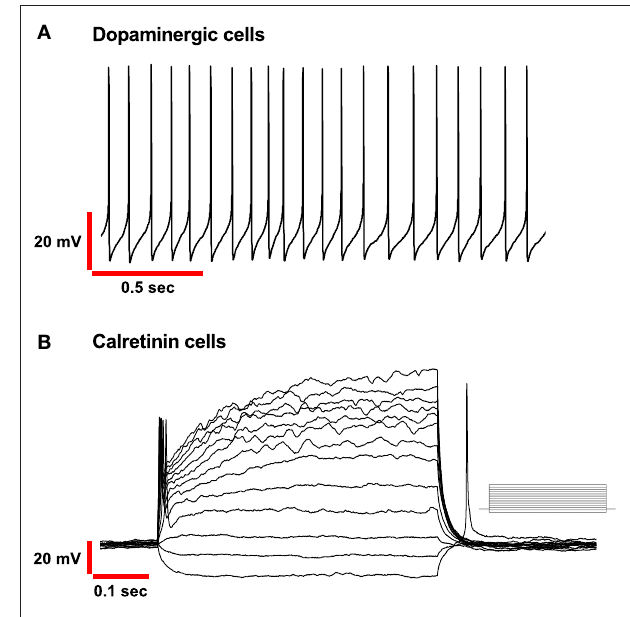
FIGURE 2 | Basic electrophysiological properties of PG Dopaminergic and Calretinin cells in OB. (A) Spontaneous autorhythmic action potentials in Dopaminergic cells recorded in current-clamp mode. Frequency range (4–12Hz). (B ) Voltage responses of Calretinin cells recorded in current-clamp mode. Only a single action potential was elicited to depolarizing injected current (from − 15pA, in increments of 10pA as shown in the